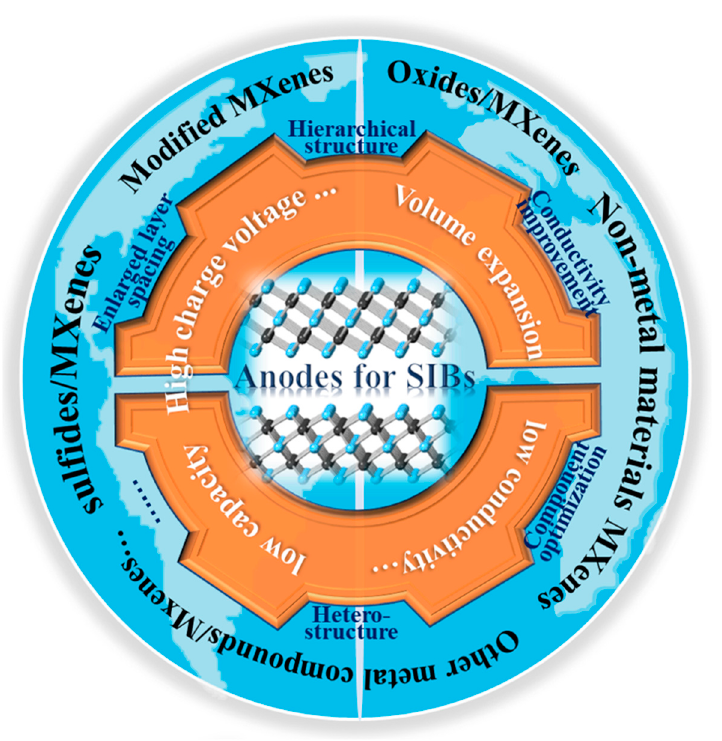
Figure 2. Problems in SIBs and the structural designs of MXene-based materials.